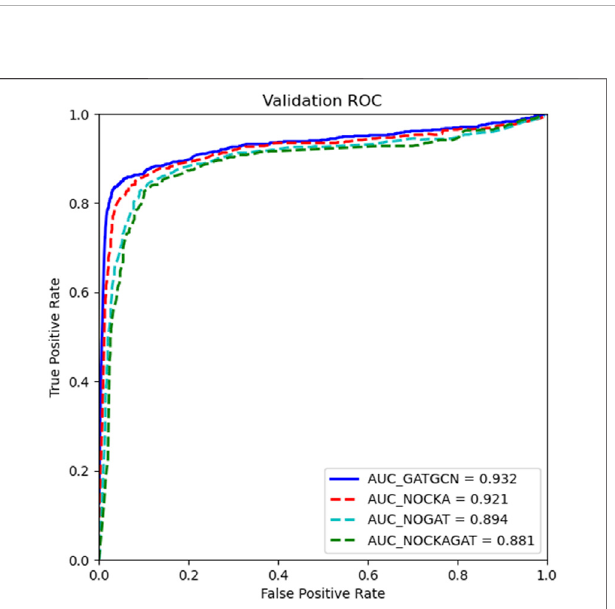
FIGURE 6 | Performance of the GATGCN based on various model